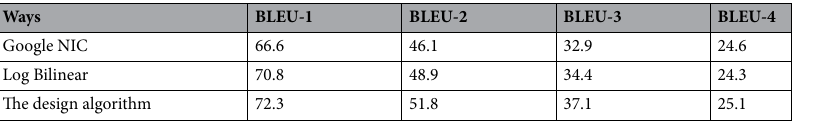
Table 7. The results of the experiments on the database MS COCO. Methods are divided into Google NIC, Log Bilinear and The design algorithm.